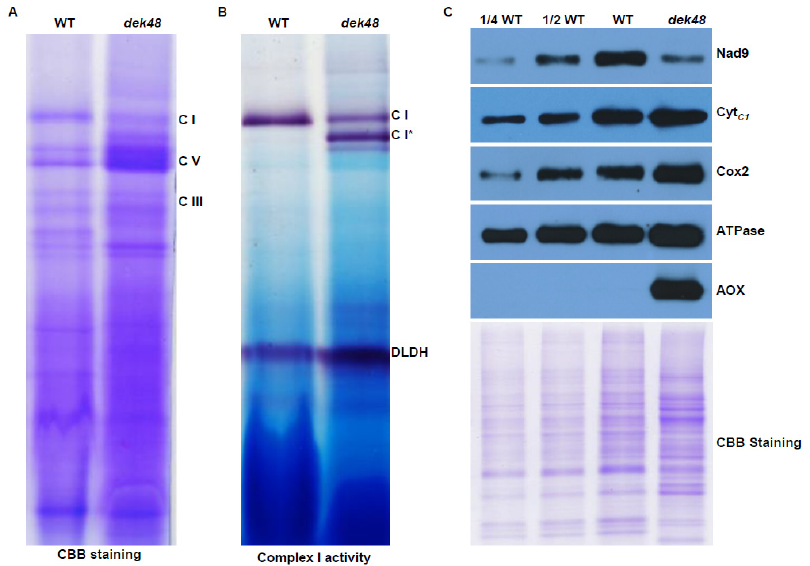
Figure 8. Blue native PAGE analyses of mitochondrial complexes in dek48-1 mutant. ( A ) Blue native (BN) gel was stained with Coomassie brilliant blue (CBB). The positions of complex I, III, and V are indicated. ( B ) In-gel NADH dehydrogenase activity of complex I. The activity of dihydrolipoamide dehydrogenase (DLDH) is used as a loading control. Asterisks indicate partially assembled complex I. ( C ) Western blot analysis with antibodies against Nad9, Cyt C1 , Cox2, ATPase α subunit, and AOX. CBB staining demonstrates that equal amounts of mitochondrial proteins were loaded.